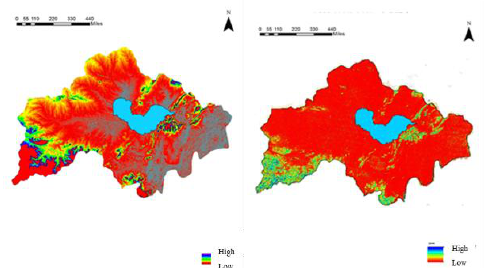
Figure 6. Relative elevation (left) and slope (right) of the Chaohu Lake basin